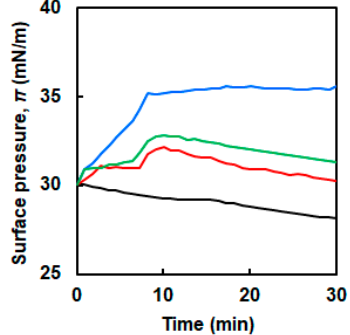
Figure 6. Changes in surface pressure of the DPPC membrane as a function of time in the absence of (black line) and presence of the EG n peptides; n = 6 (blue line), 12 (red line), 24 (green line).